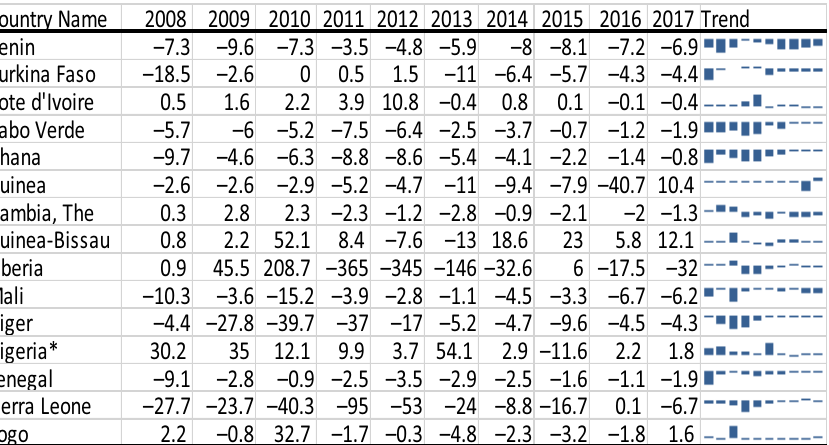
Solvency ratio of external debt (SRED) of ECOWAS member